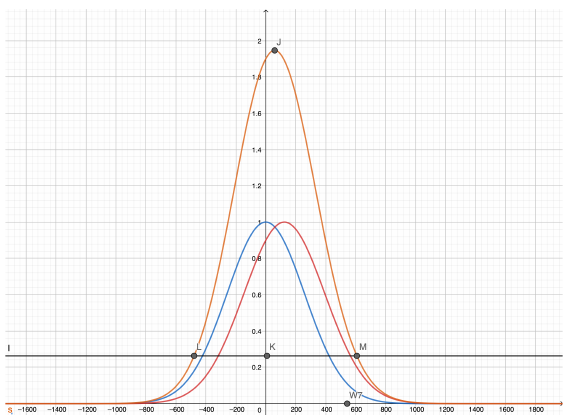
Fig. 5 . Incident points of the 8 beams. The beams considered merged are the ones incident at (Bp1-Bp2), (Bp4-Bp5) and (Bp6-Bp7)